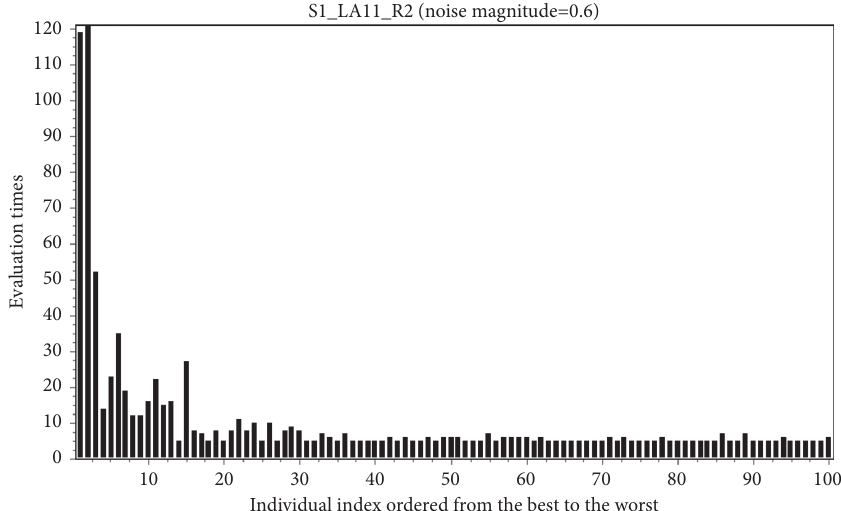
Figure 3: Computing budget allocation of OCBAT in DEA_UHT for S1_LA11_R2_ T